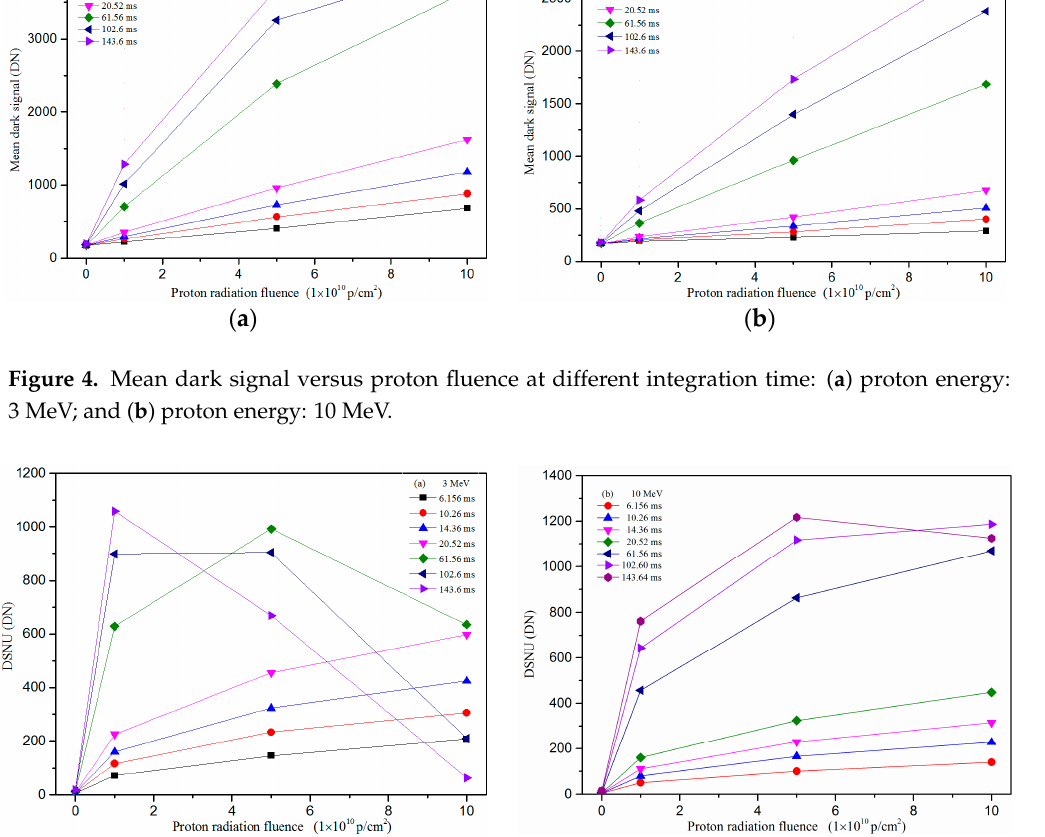
Figure 5. DSNU versus proton fluence at different integration time: ( a ) proton energy: 3 MeV; and ( b ) proton energy: 10 MeV.